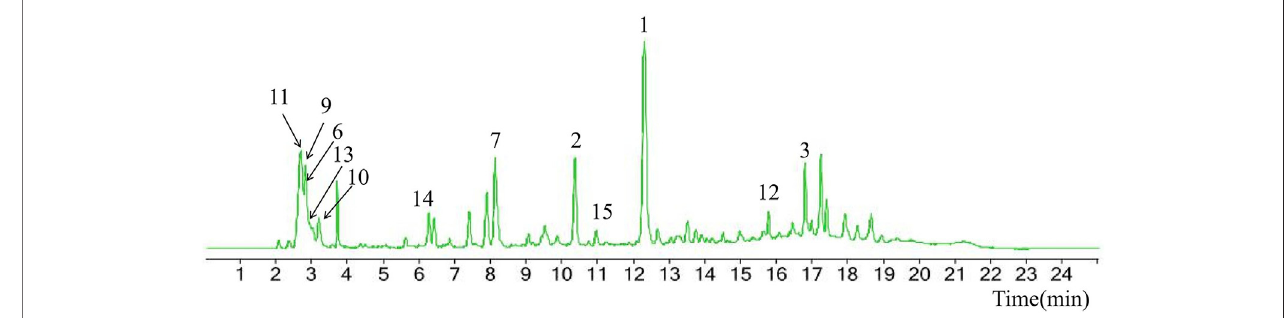
FIGURE 5 | TICs of GF compounds at a negative ion mode. The total ion chrtograms (TICs) of GF extract, 1, 2, three on behalf of geniposide, genipin-1- β -D- gentiobioside, crocin-1, respectively; 6,7 and 9 – 15 represent quinic acid, gardenoside, D -glucuronic acid, L -malic acid, mannitol, rutin, D -glucaric acid, shanzhiside, chlorogenic acid, and genipin-1- β -D-gentioside,